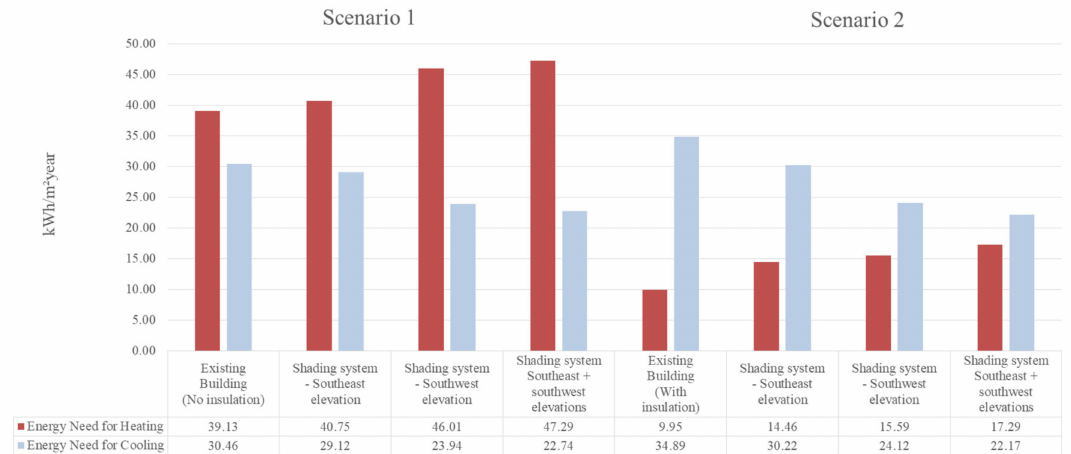
Figure 8. Calculation of the energy need (kWh/m 2 year) and Energy Certification with HULC—scenarios 1 and 2.